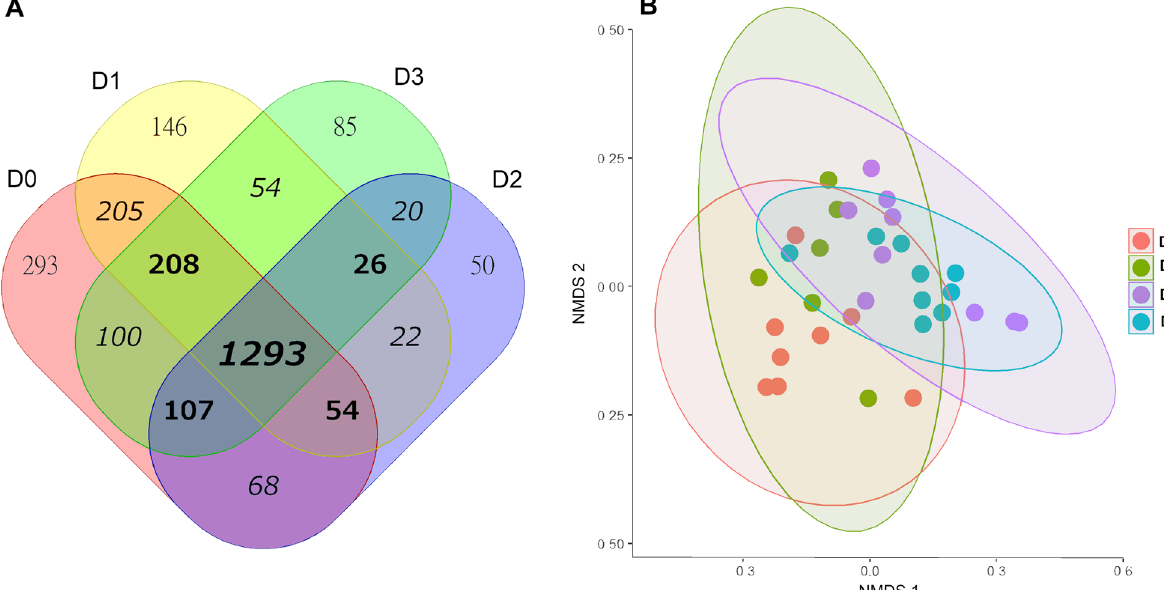
Fig. 6 Core community analysis of the four scenarios studied. A Venn Diagram of genera shared across and exclusive to localities is shown in panel ( A ). A Non‑metric Multidimensional Scaling plot from a Jaccard distance matrix of presence/absence data is depicted in panel ( B